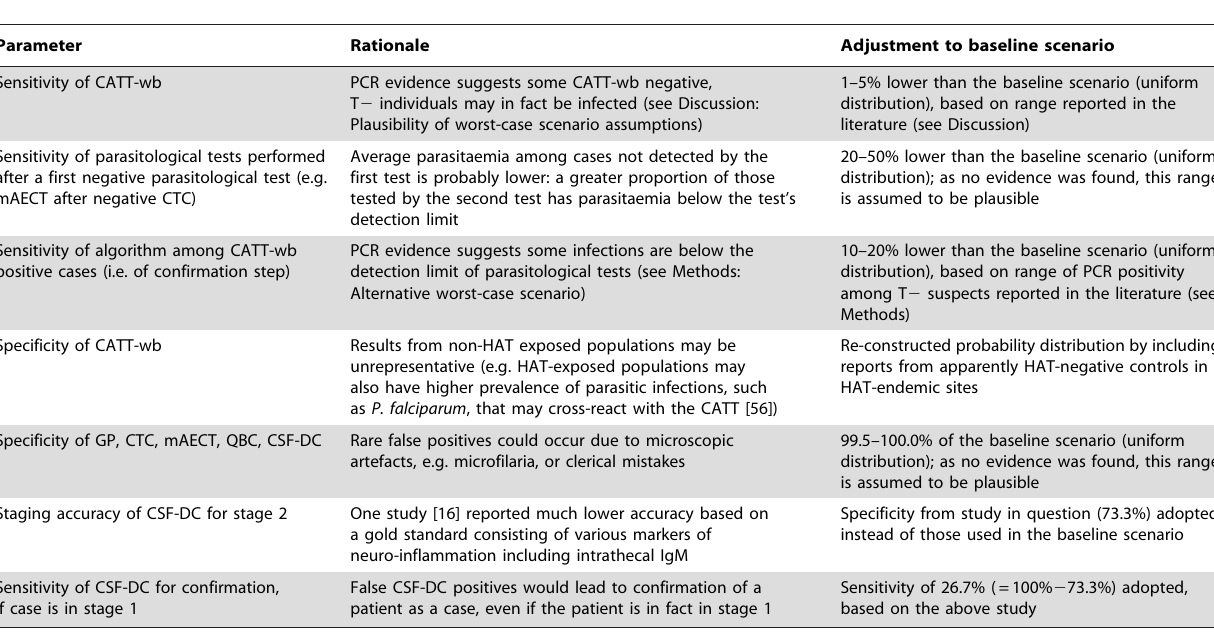
Table 2. Assumptions made in the worst-case scenario